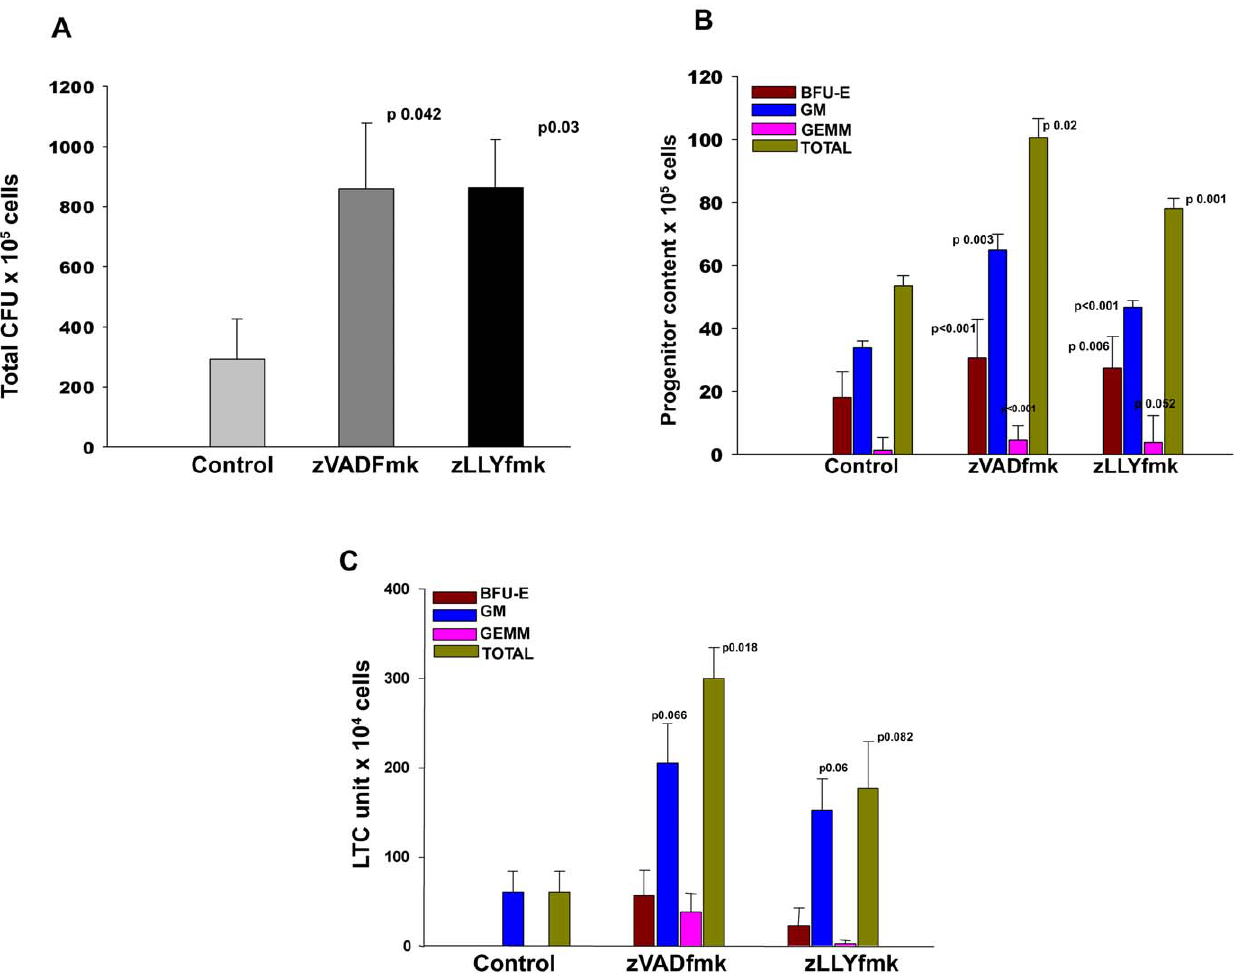
Figure 4. Improved CFU and LTC output of the expanded HSPCs. The in vitro functional properties of the expanded HSPCs significantly improved upon protease inhibition. (A) Colony formation assay on a semi- solid methyl cellulose media was carried out. After 14 days of incubation, the three major colonies (BFU- E, GM, and GEMM) were scored under an inverted microscope. The total colonies were normalized to the cell yield. There was a 3.5 fold increase in total progenitors in the cells expanded in the presence of zVADfmk and zLLYfmk. Data are represented as mean 6 standard deviation of four different CB samples (n=4). (B) A representative data showing the presence of differential colonies: BFU E, GM and GEMM formed in the three sets. (C) LTC assay was carried out to assess the presence of more primitive stem cells within the cultured HSPCs. At the end of fifth week, the adherent and non adherent cells were pooled and subjected to colony formation and the major colonies formed were scored. The cells expanded in the presence of either of the protease inhibitors preserved the LTC units to a higher extent. There were no BFU-E and GEMM colonies in the control. The zVADfmk/zLLYfmk sets formed both BFU-E and GEMM in addition to GM colonies. Data from a representative experiment is shown